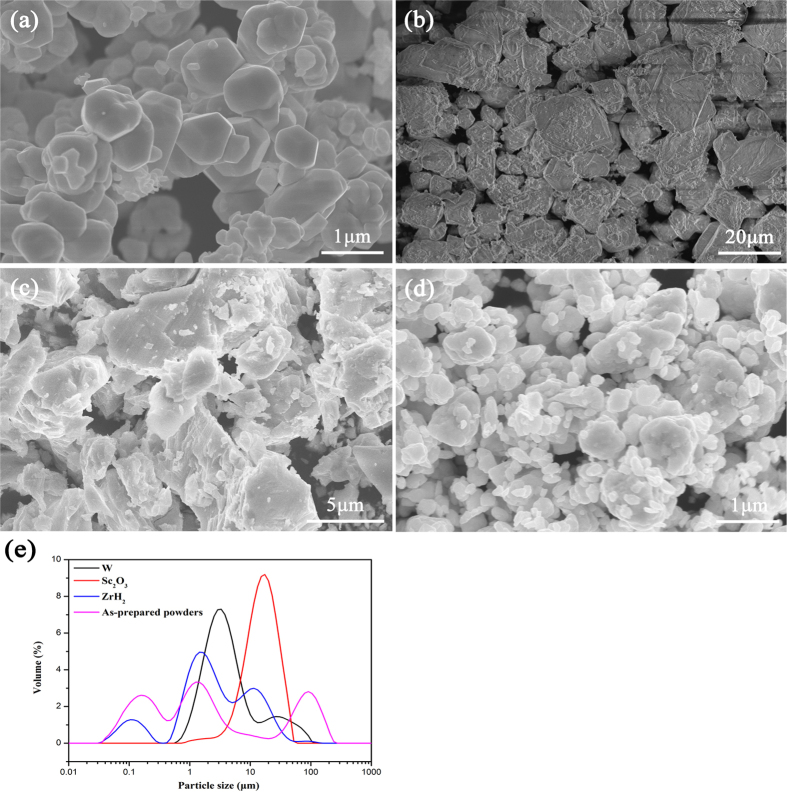
SEM images of the powders: (a) W powder; (b) Sc2O3 powder; (c) ZrH2 powder; (d) as–prepared W–ZrH2/Sc2O3 powder and particle size distribution of powders: (e).